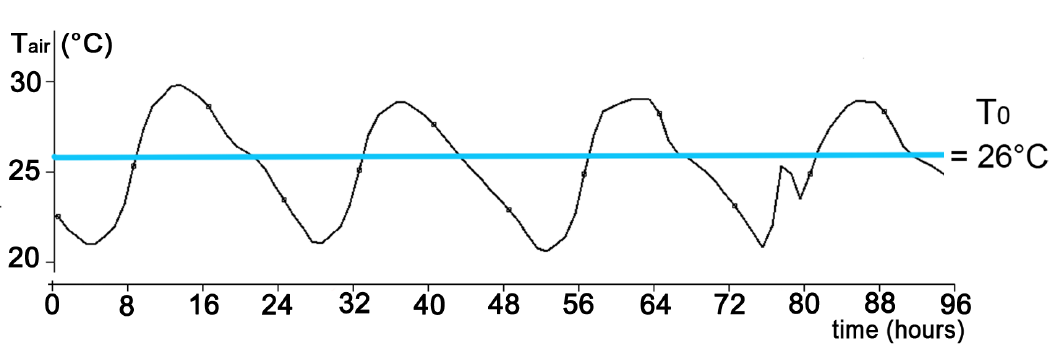
Figure 2. Outdoor air temperature T air trend (Rome) and const T 0 in case study days (17–20